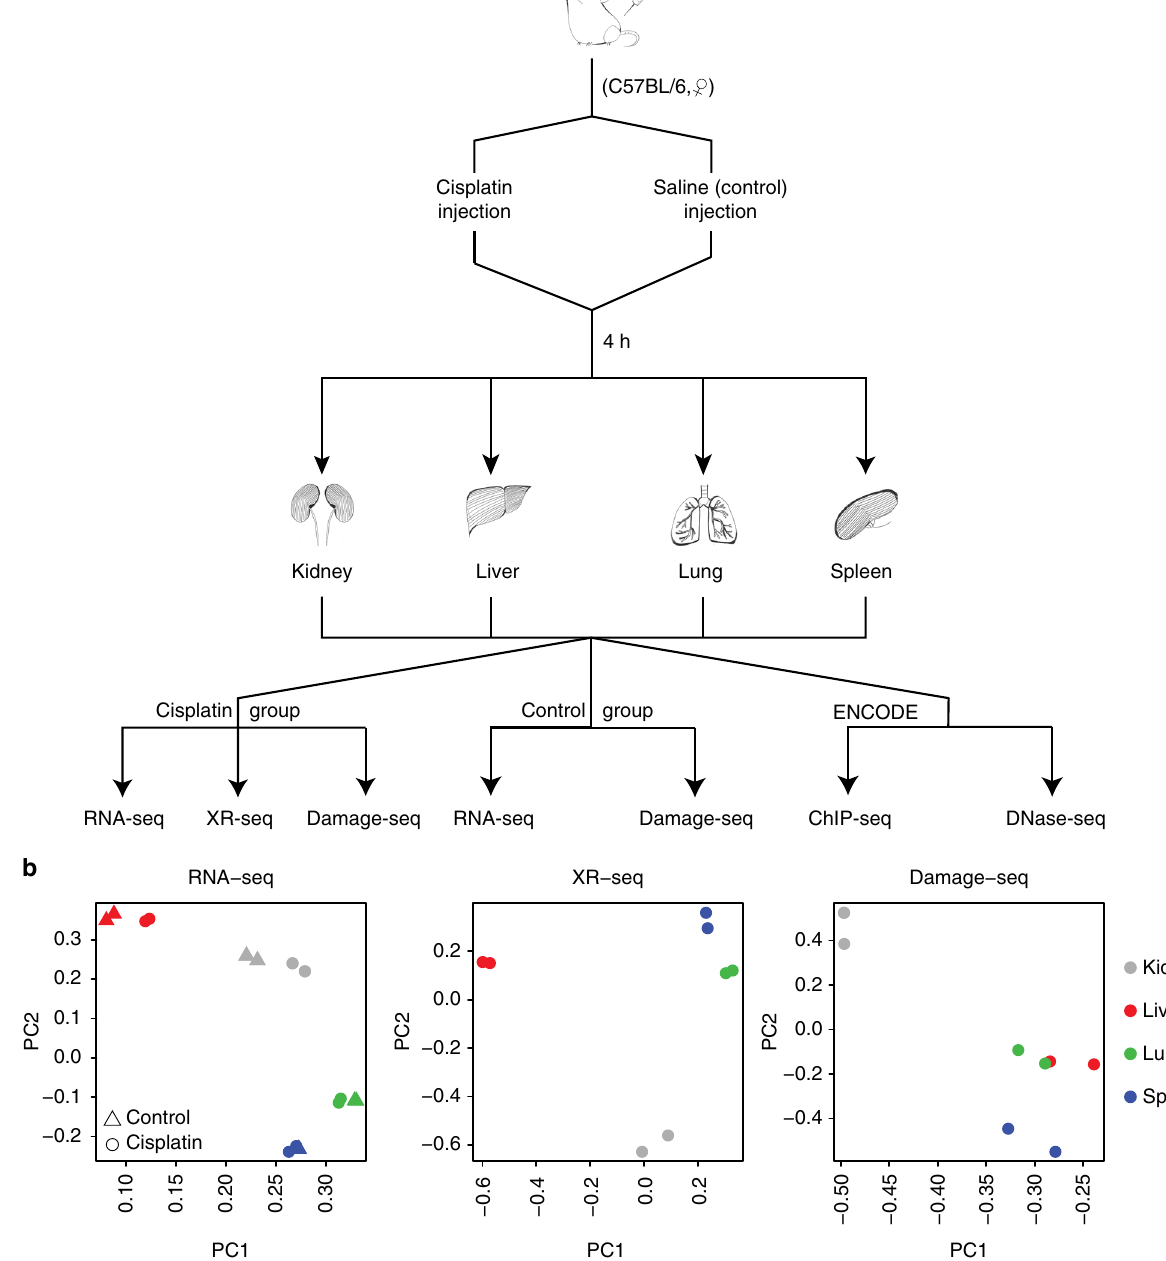
Fig. 1 Overview of experimental design. a Outline of the experimental design. Cisplatin was administered by intraperitoneal injection in mouse. DNA damage, excision repair, and gene expression were assayed by Damage-seq, XR-seq, and RNA-seq. b PCA reveals tissue-speci fi c damage, repair, and transcription across four mouse organs. All experiments were performed with two biological